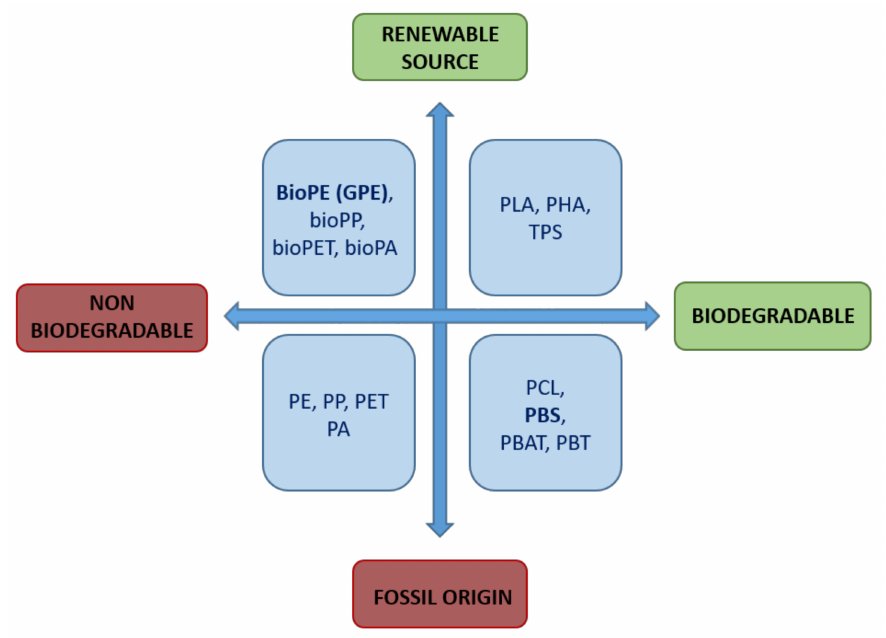
Figure 2. Types of